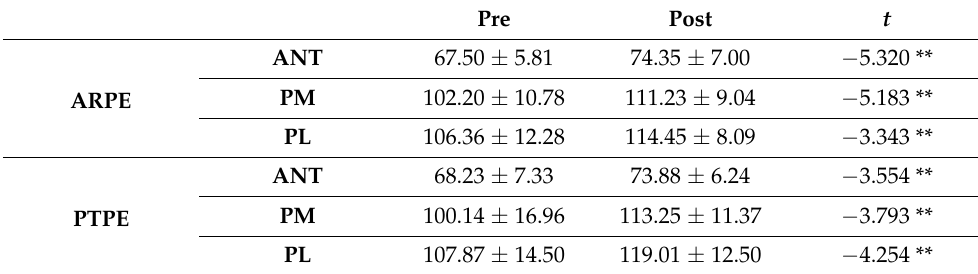
Mean ± standard deviation, ARPE: augmented reality proprioceptive exercise, PTPE: physical ther- apy proprioceptive exercise. Table 7. Comparison of dynamic balance between groups after intervention. Table 9. Comparison of flexibility within and between groups before and after intervention appli- cation. Pre Post ARPE